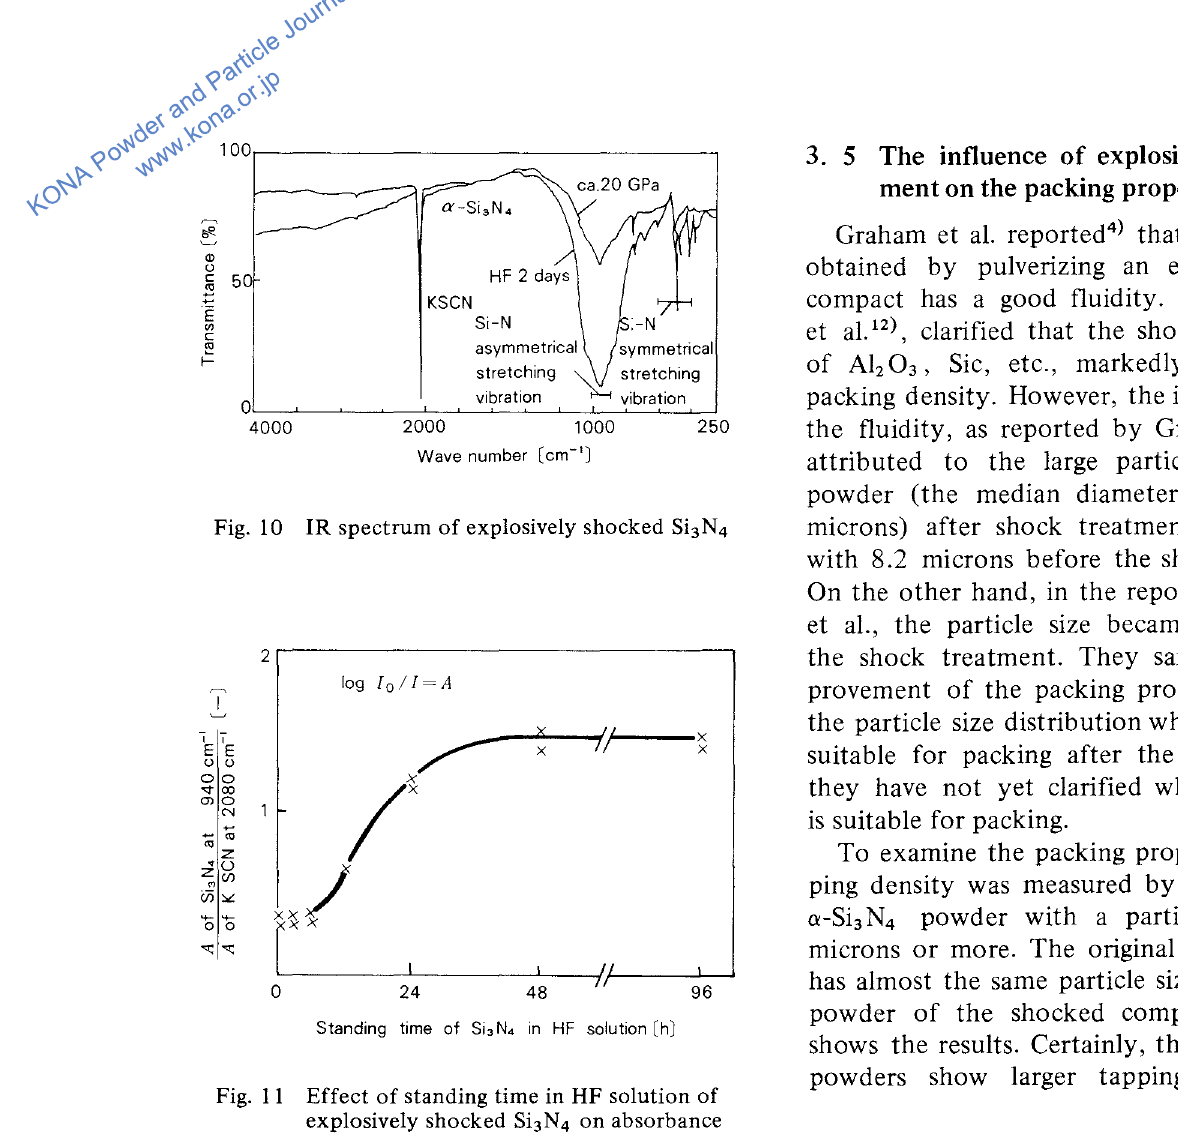
Fig. 11 Effect of standing time in HF solution of explosively shocked Si 3 N 4 on absorbance ratio